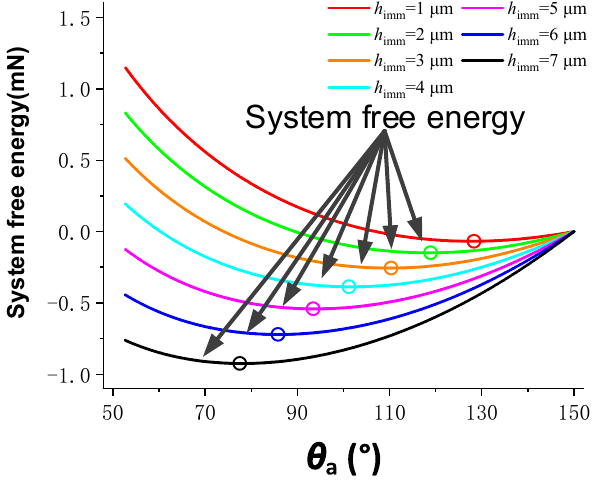
Figure 3. Calculation results of the composite infiltration model. The relationship between the steady state apparent contact angle and the droplet linear. As the depth of infiltration increased, the apparent contact angle gradually decreased, because the droplet infiltration mode gradually approached the full infiltration mode.